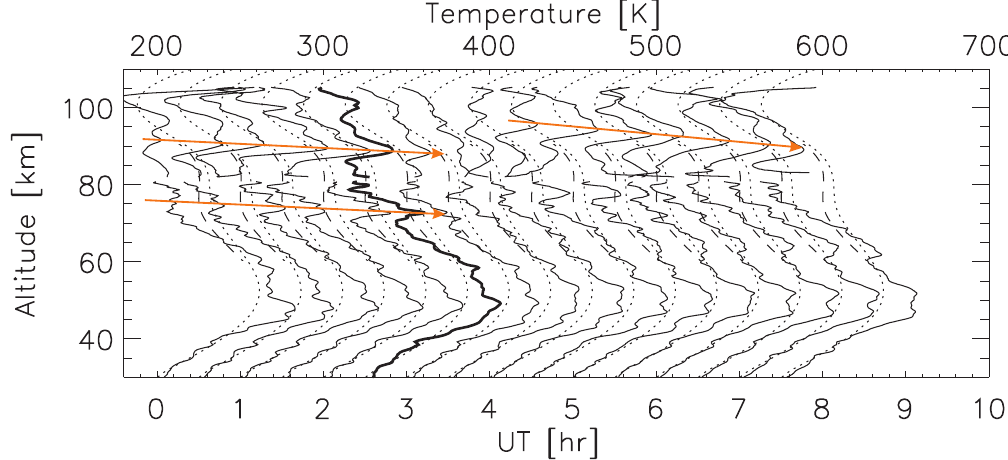
Fig. 2. Combined RMR and sodium resonance lidar temperature profiles for first eight hours of 19 December 2010 obtained from ALOMAR observatory. The profiles are averaged over one hour period. Please note the temperature perturbation downward progression denoted with the orange